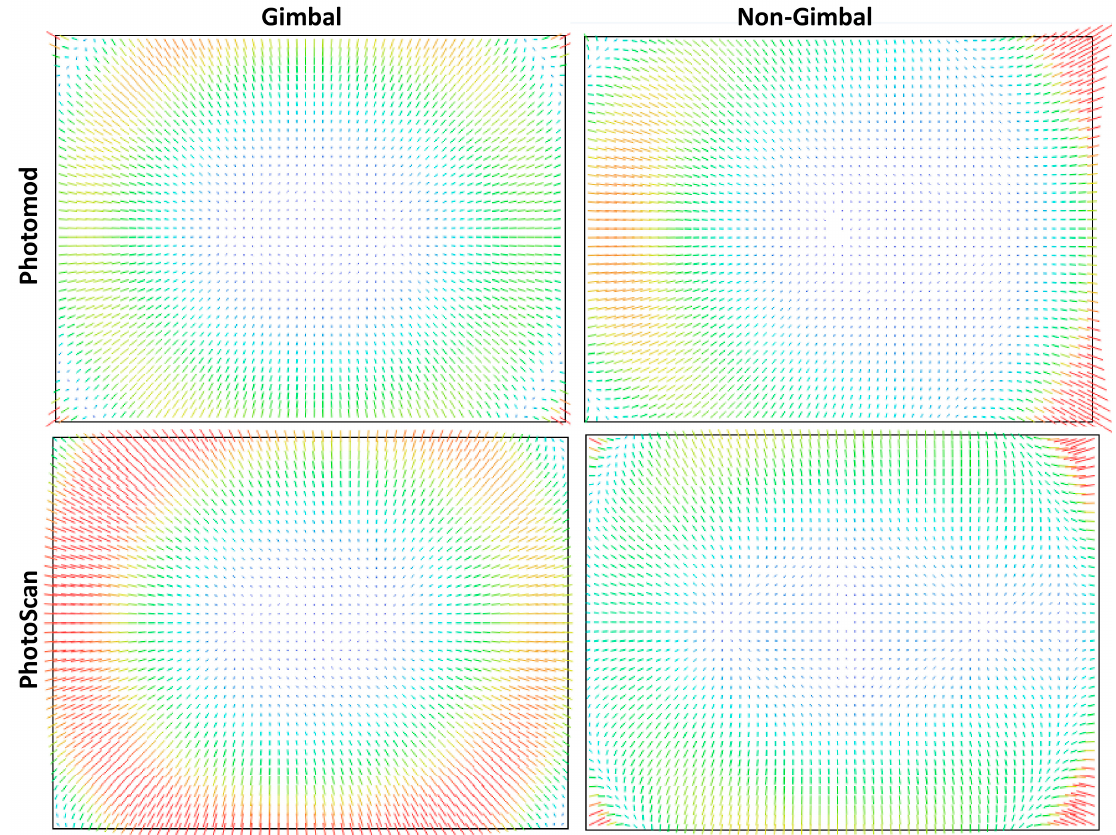
Figure 7. GoPro camera lens distortion plots based on camera self-calibration results in Photomod and PhotoScan . The estimated camera distortions are presented at the same scale (×161) across all of the figures.